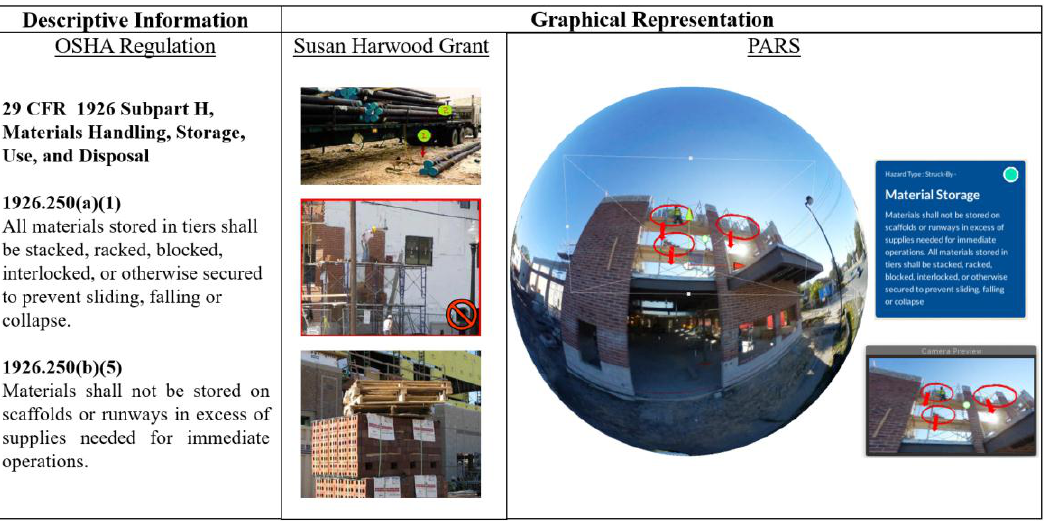
Figure 7. Safety Augmentation—Material Storage.